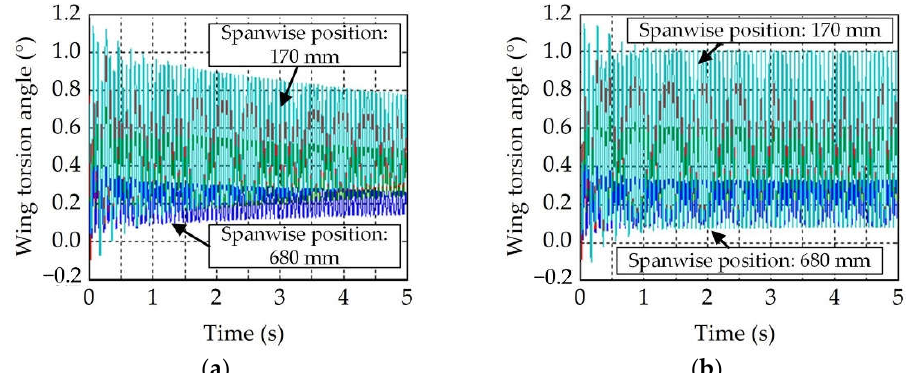
Figure 6. Wing torsion responses at different wind speeds: ( a ) 20 m/s; ( b ) 21 m/s.